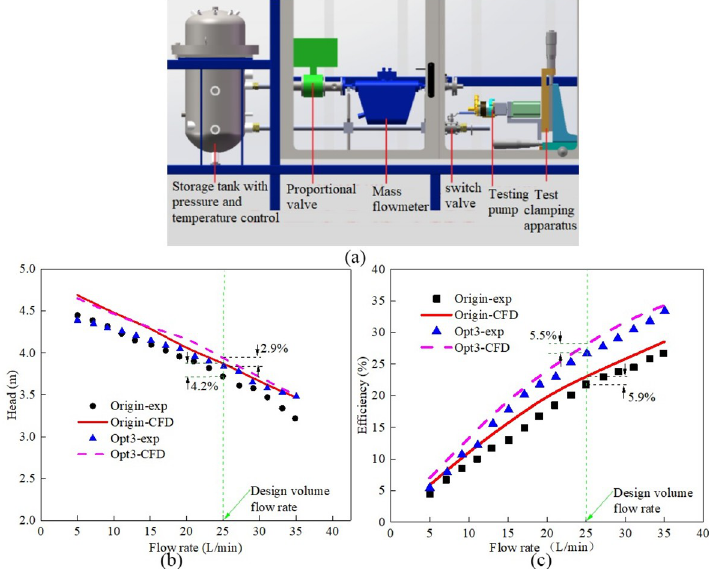
Fig 9. Experimental validation analysis: (a) Testing apparatus; (b) Head curves; (c) Efficiency